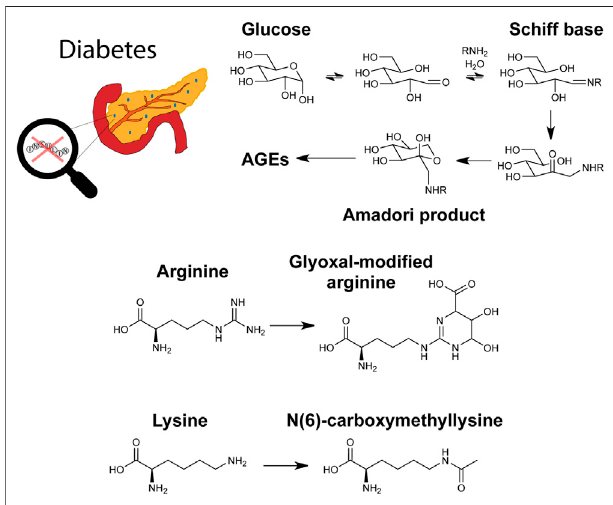
FIGURE 4 | Graphical depiction of diabetes, a glycation pathway relevant to hemoglobin, and the advanced glycation end products (AGEs) glyoxal-modi fi ed arginine and N(6)-carboxymethyllysine.